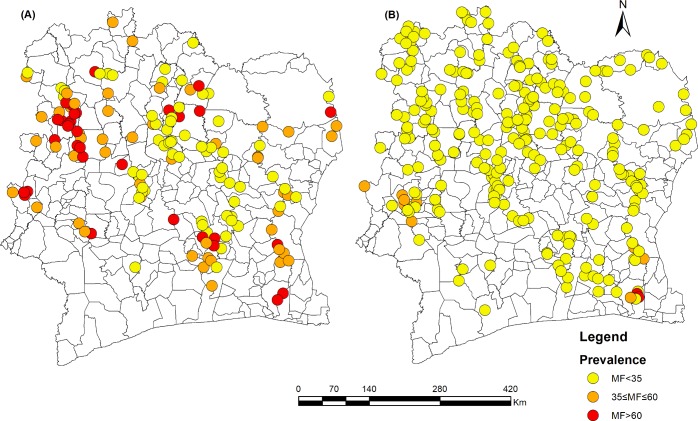
Baseline onchocerciasis MF prevalence of onchocerciasis assessed by microfilaria detection in skin snips.(A) 1975–1991 Baseline evaluation prior to aerial spraying; (B) 1992–2016 baseline evaluations of MF prevalence in additional districts during CDTi.